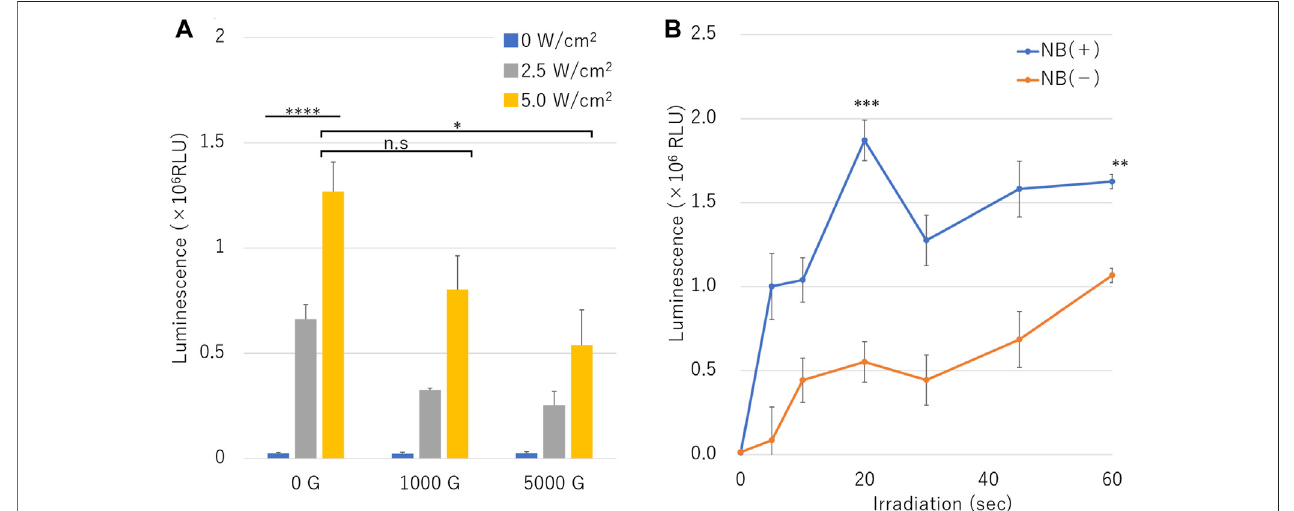
FIGURE 7 | pDNA transfection ef fi ciency by sonoporation using different sized nanobubbles or irradiation time. (A) Expression of secreted luciferase protein by sonoporation using combinations of centrifuged bubbles and ultrasound. (B) Ultrasonic irradiation time dependent pro fi le of luciferase expression in conditions with or withoutnanobubbles.(RLU,relativeluminescenceunits).Thedataarepresentedasthemean±standarderrorofthemean(s.e.m.).Statisticalsigni fi cancewasassessed (A) one-way ANOVA with Tukey ’ s multiple comparisons post-test or (B) unpaired t -test including Welch ’ s correction (* p < 0.05, *** p < 0.001, **** p < 0.0001, n. s not signi fi cant) ( N =